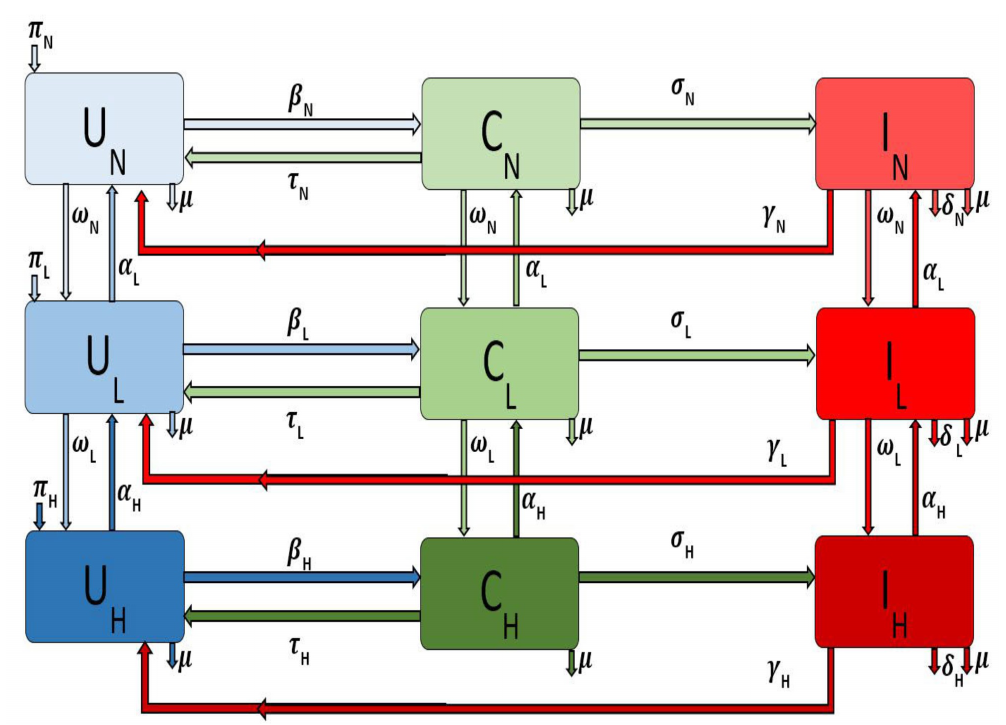
Figure 1. Flow diagram of the Methicillin-resistant staphylococcus aureus (MRSA) model Equation (1) with injection drug users (IDUs) in a single